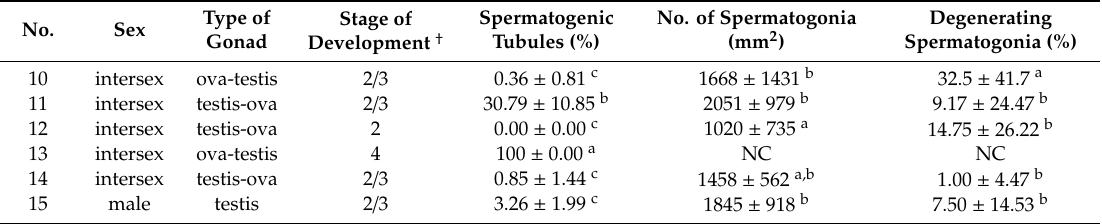
Table 2. Characteristics of the testicular component of RAS-reared Russian sturgeon on the 1600th day after